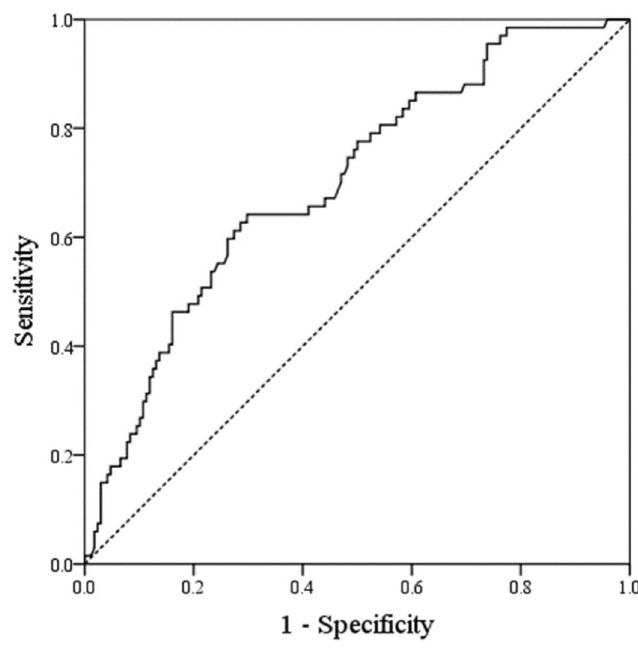
Figure 1. ROC analysis of GDF-15 levels in predicting diabetic retinopathy in individuals with type 2 diabetes. AUC = 0.701 ( p < 0.001), 95% CI: 0.629–0.774. Identified GDF-15 cutoff value = 1336 ng/L; sensitivity: 64.2%; specificity: 70.2%. ROC, receiver operating characteristic; AUC, area under the curve, GDF-15, growth differentiation